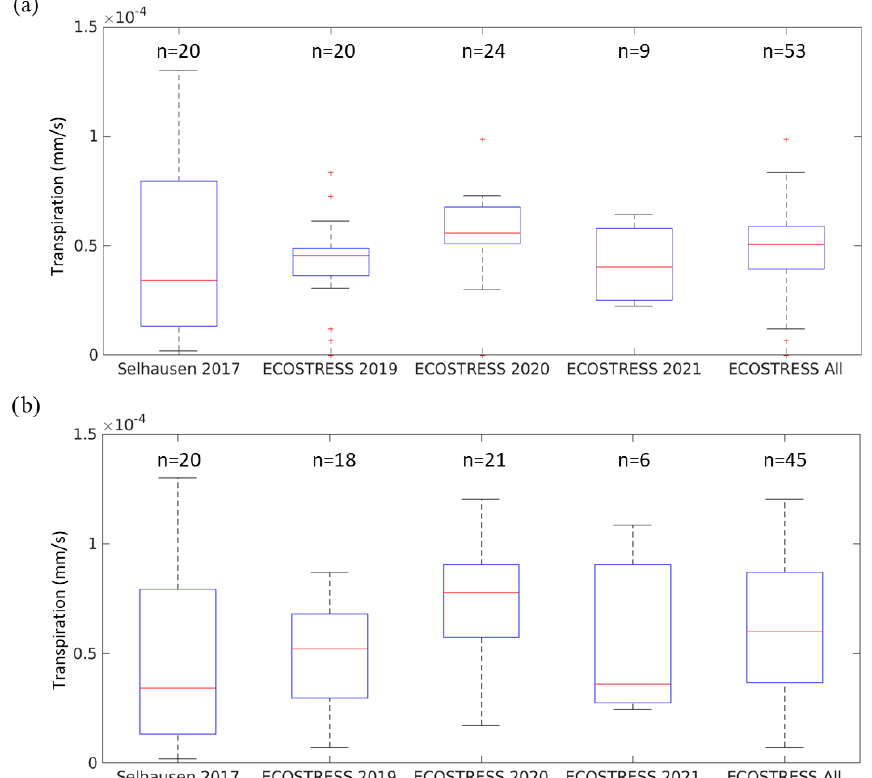
Figure 15. Boxplots of estimated transpiration rates TR [mms − 1 ] comparing the field-based estimates presented for the Selhausen test site (see Fig. 14) and (a) the space-borne ECOSTRESS daily product and (b) the instantaneous product. The number of samples ( n ) is indicated at the top of each box. For each box, the red line shows the median, top and bottom edges are percentiles 75 and 25, respectively, top and bottom whiskers are percentiles 95 and 5, respectively, and red crosses indicate